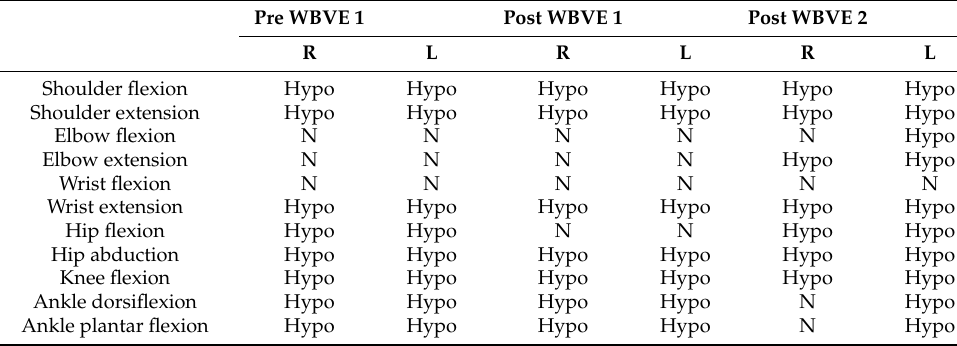
Table 4. WBVE results in tone assessed through passive joint